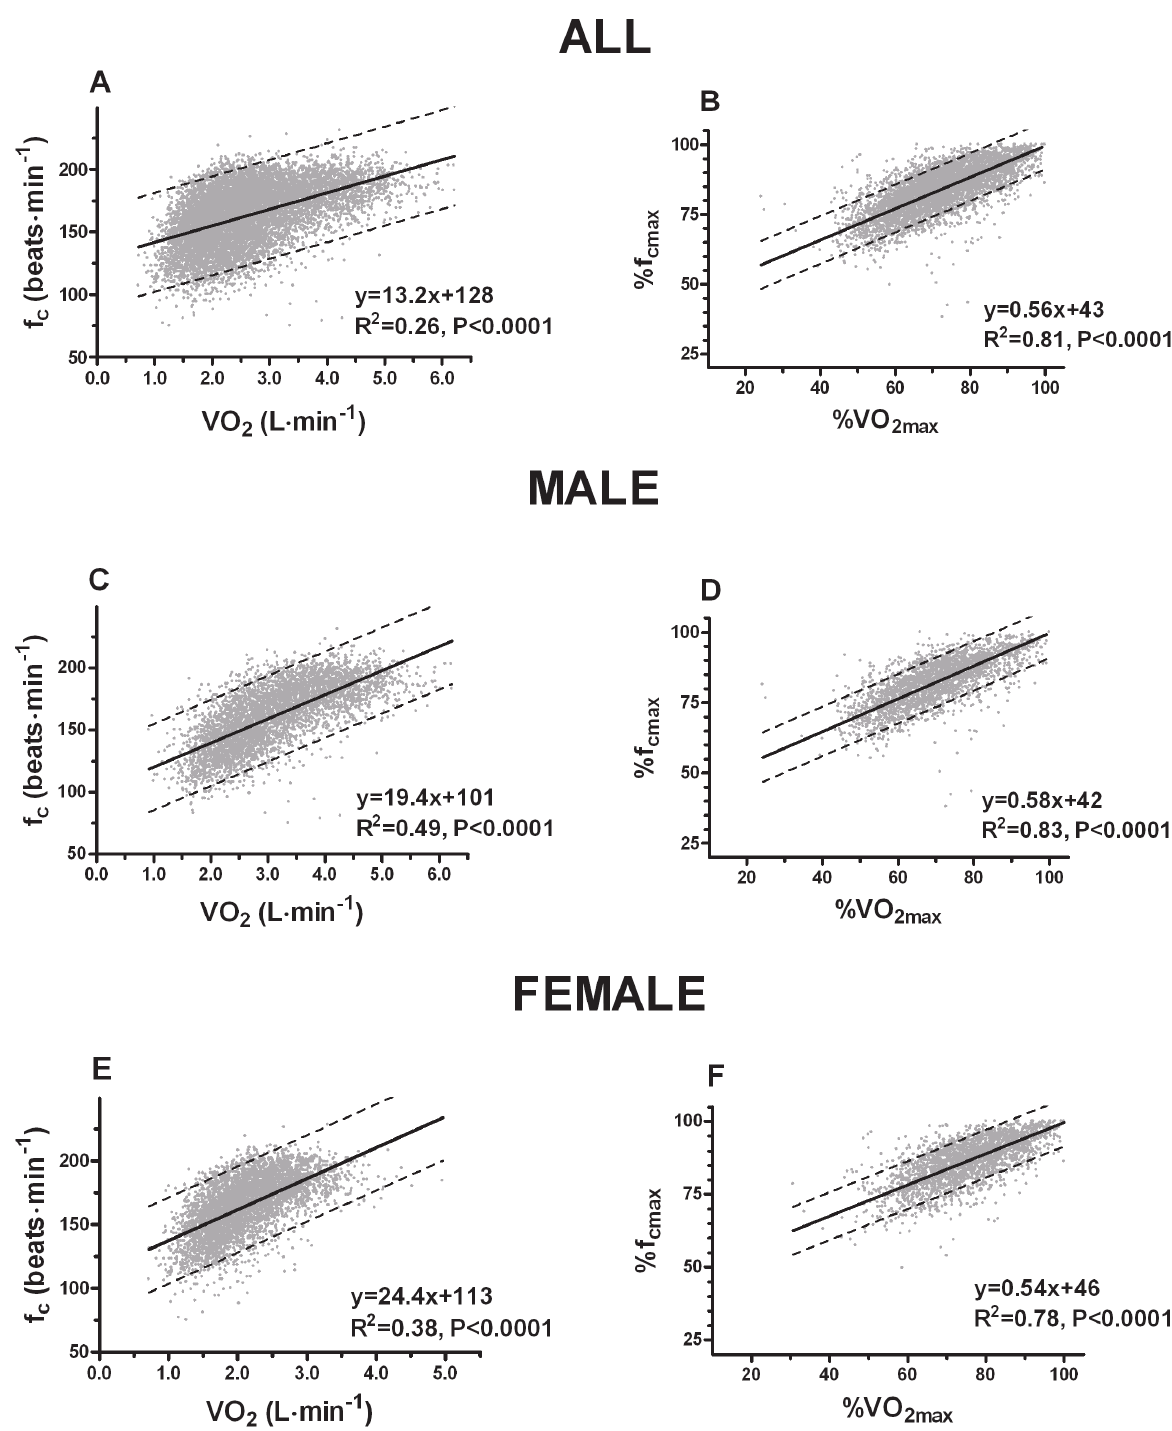
Figure 1. Correlations between oxygen uptake (VO 2) and heart rate (f c ).